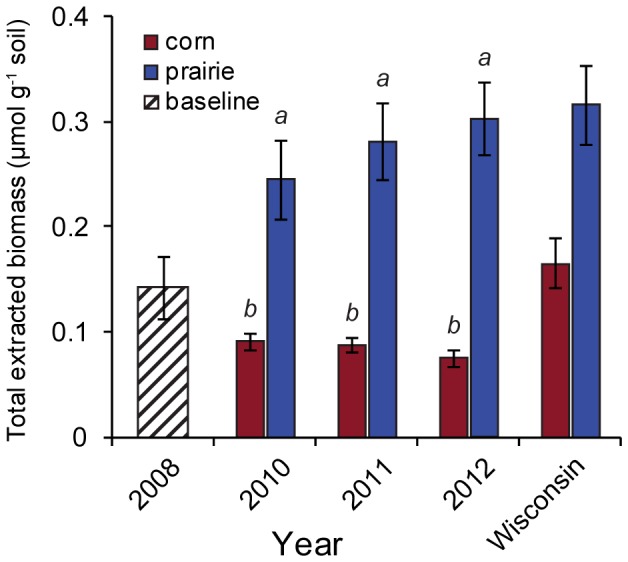
Total sample biomass (µmol/g) in corn and prairie sites.Error bars are +1 standard error. Baseline data adapted from Liang et al. [18], statewide Wisconsin data adapted from Liang et al. [12] based on observations from 2008. Bars are ±1 standard error. Groups sharing a letter are not significantly different at a P<0.05 significance level.